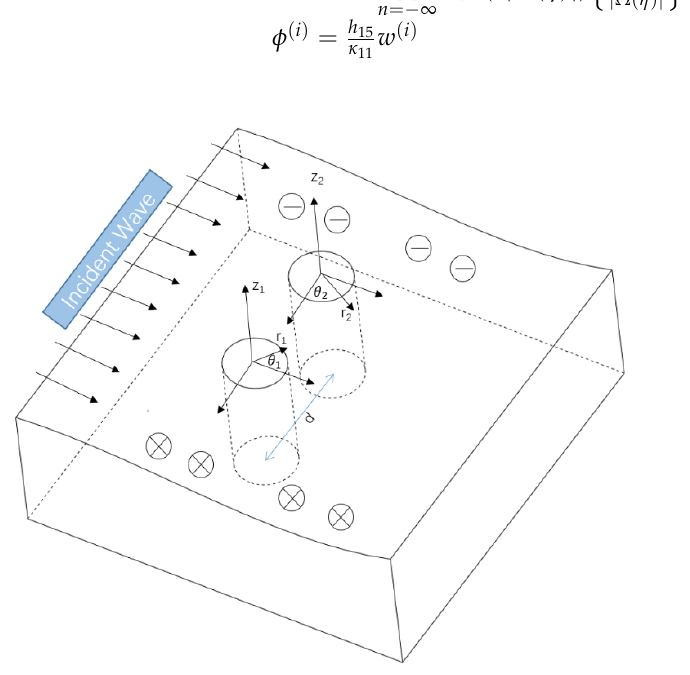
Figure 1. Elastic wave incident in piezomagnetic composites with double openings.